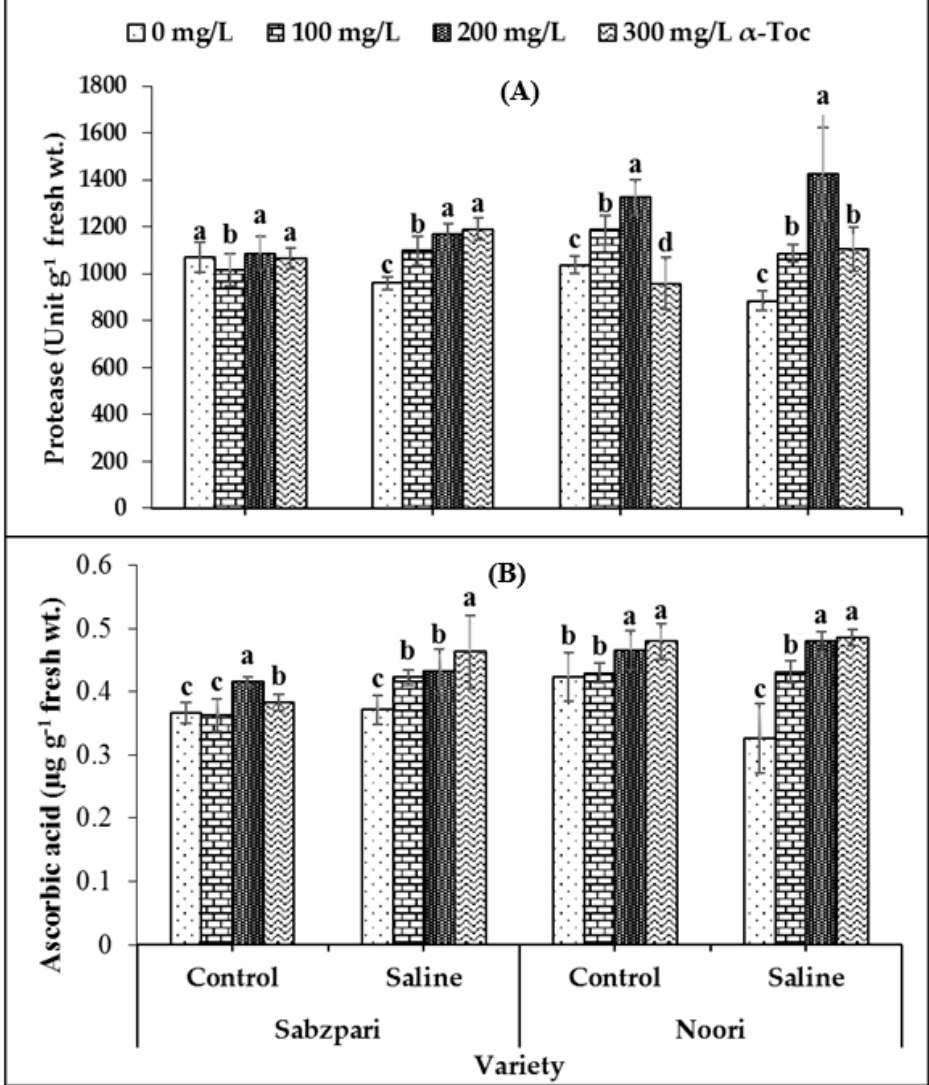
Figure 3. Effect of different levels of α -Toc under saline and non-saline conditions on ( A ) activities of protease and ( B ) ascorbic acid of okra varieties. Values represent means ± S.D. Significant differences among row spacing were measured by the least significant difference (LSD) at p > 0.05 and indicated by different letters. S. D. stands for standard deviation.